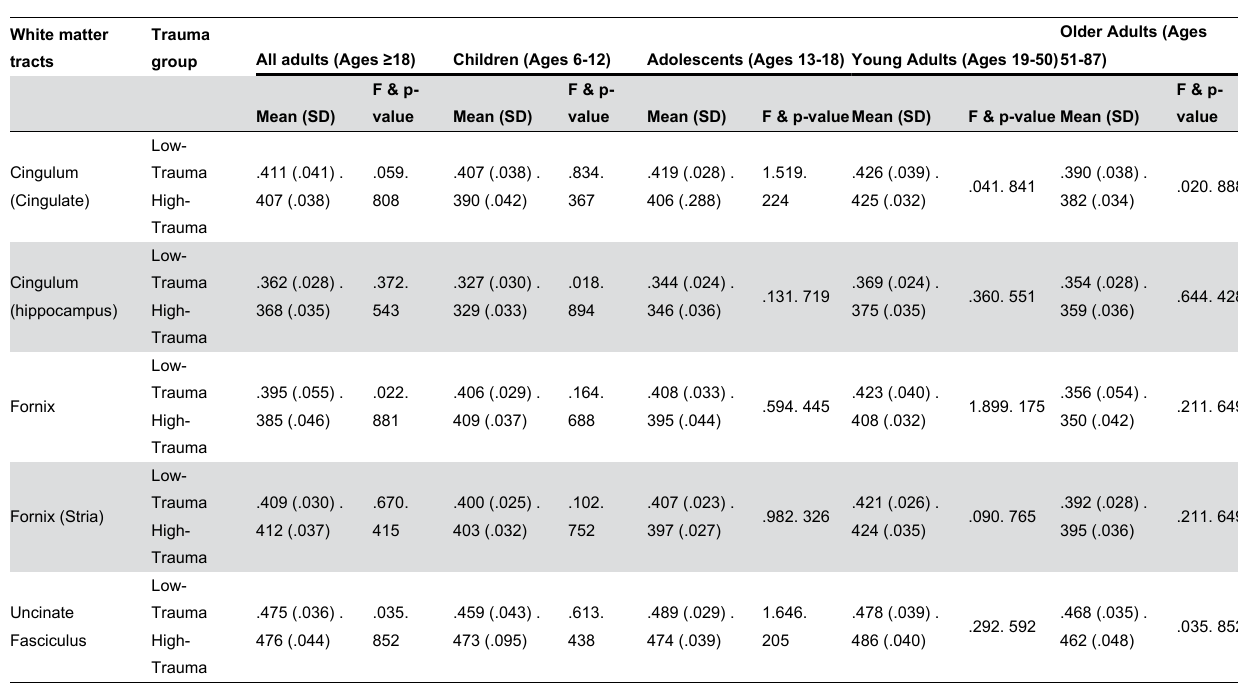
Table 3. Means and statistical values for Fractional Anisotropy for the cingulate & limbic white matter tracts as a function of early life trauma and